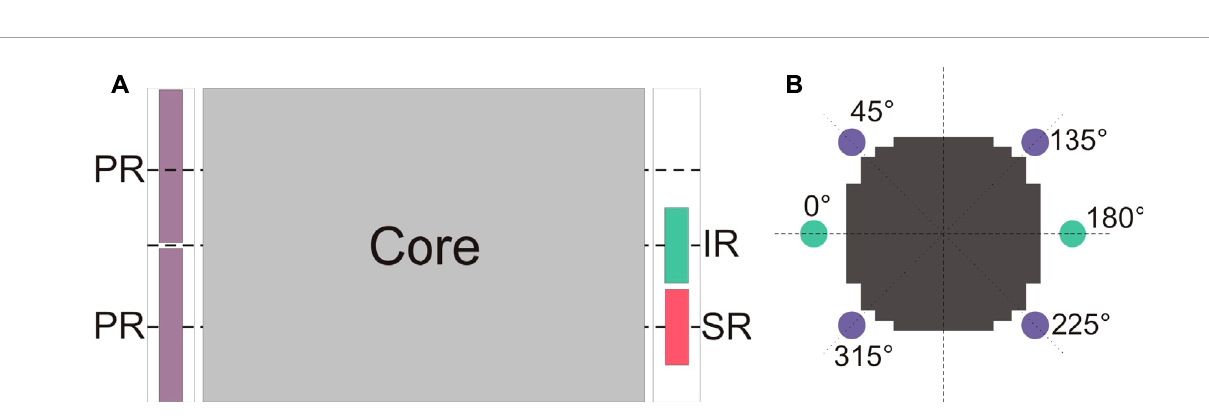
Inside the reactor core are 33 rod cluster control